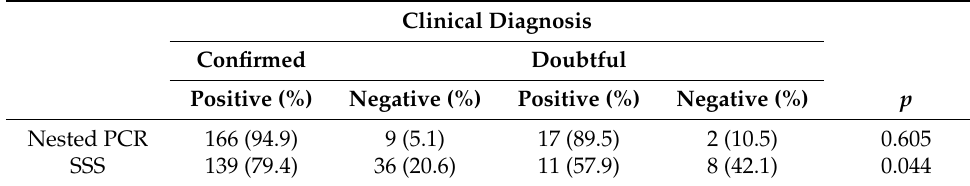
Figure 4. Agarose gel (2%) electrophoresis of the Hae III restriction enzyme digested product of modified nested ITS1 PCR (L: 100 bp DNA ladder, 1–16: clinical samples from the cohort of CL cases, NC: negative control). Table 3. Detection of clinical cases of CL by SSS and nested